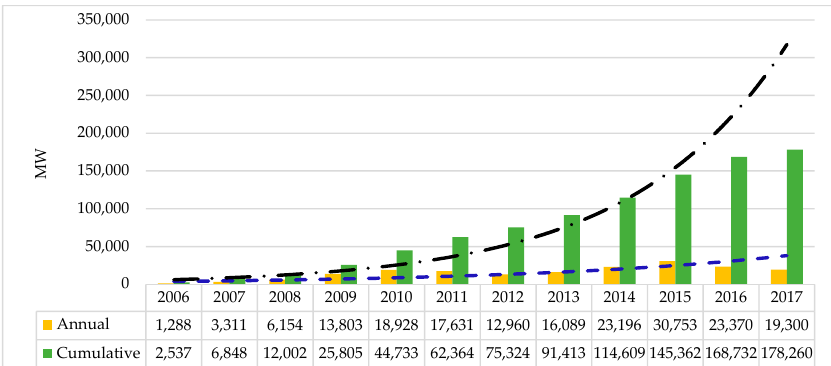
Figure 3. Smiling Curve of wind power industry.